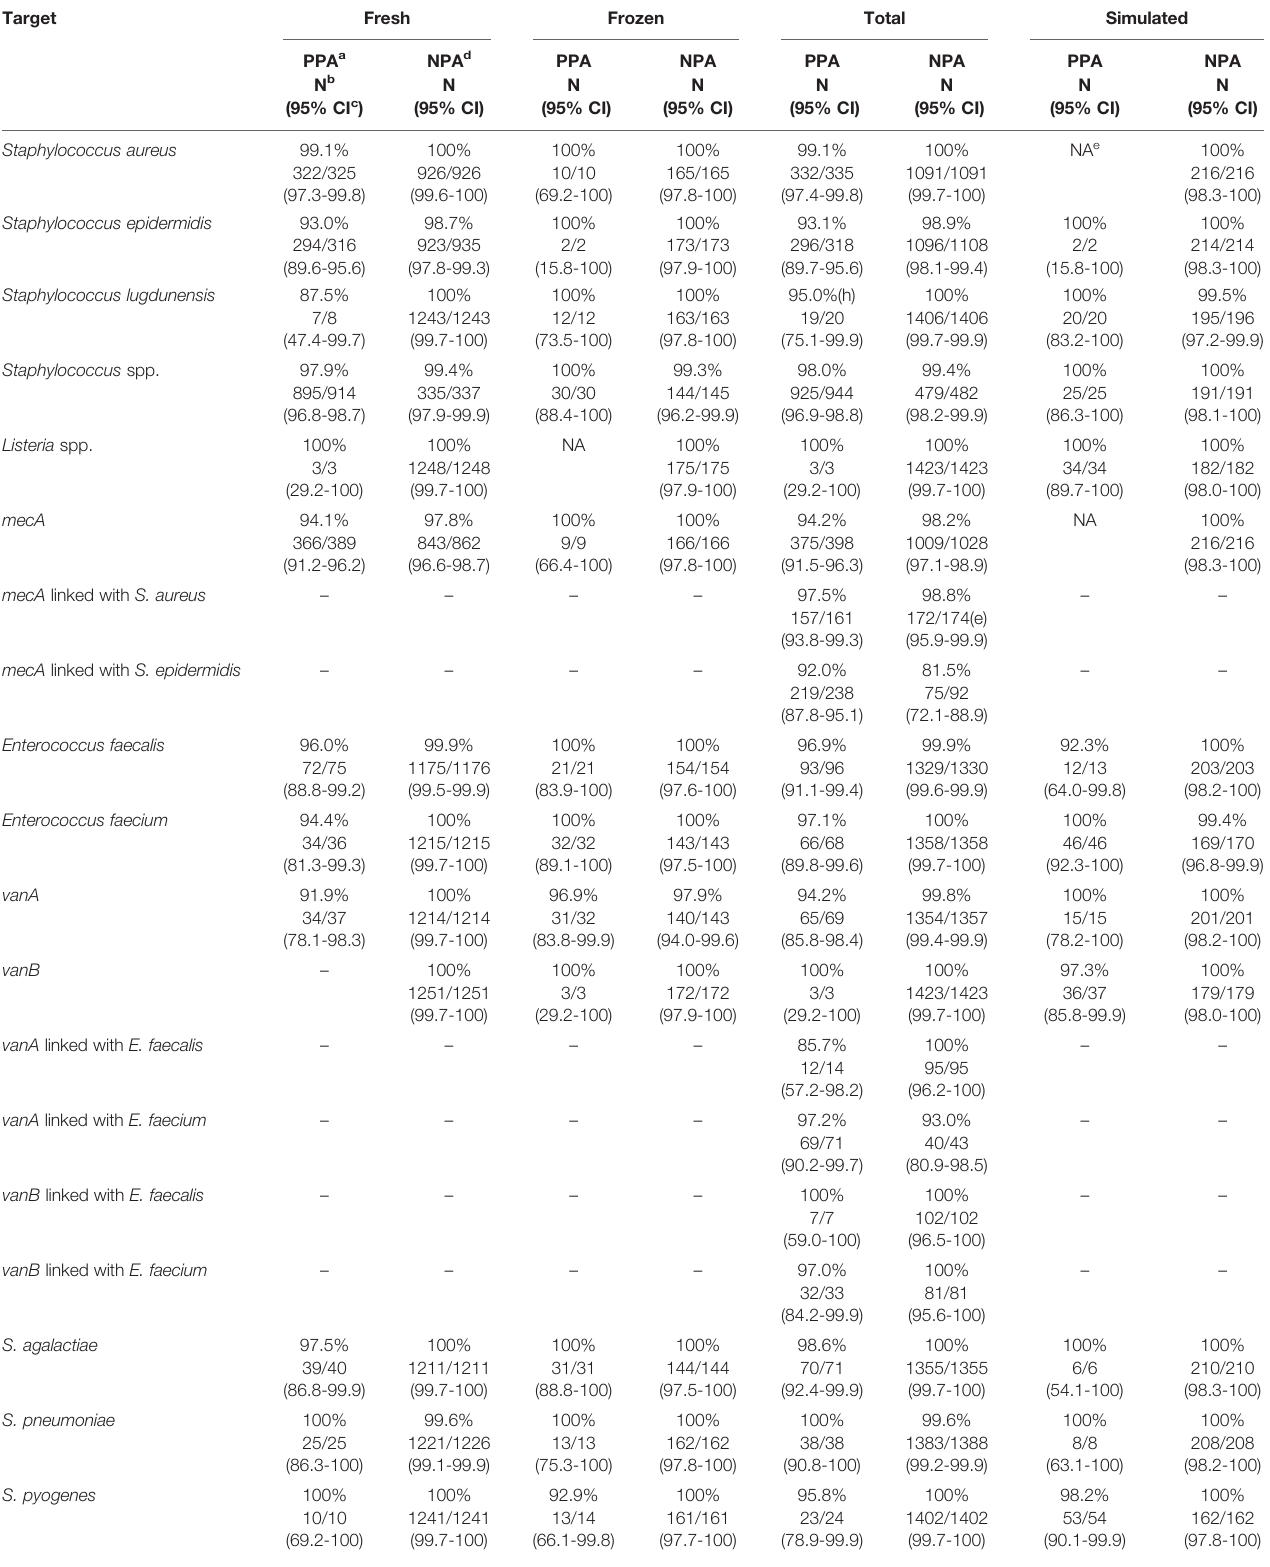
TABLE 3 | Summary of clinical performance for the VERIGENE Gram-Positive Blood Culture